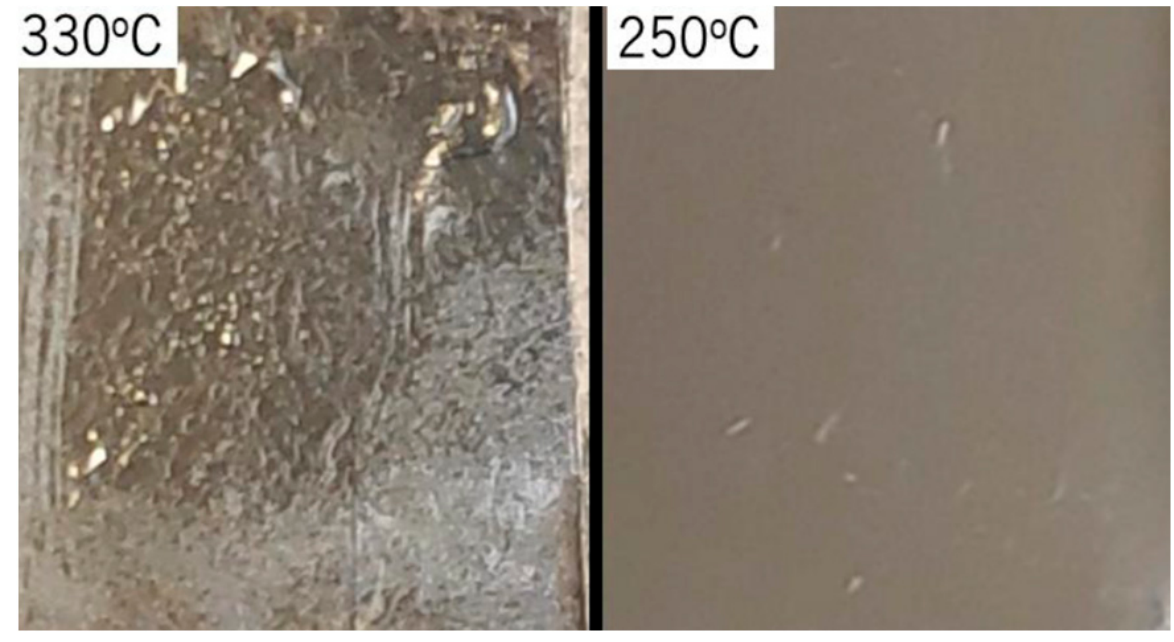
Figure 4. Metallic films were deposited on the polyimide after the annealing process.